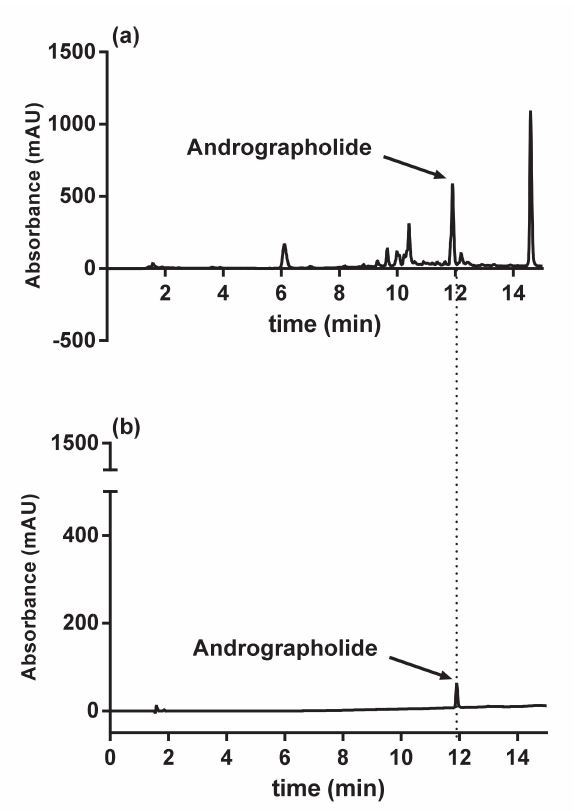
Figure 2. HPLC results of ( a ) andrographolide from methanolic extract of Andrographis paniculata ; ( b ) andrographolide